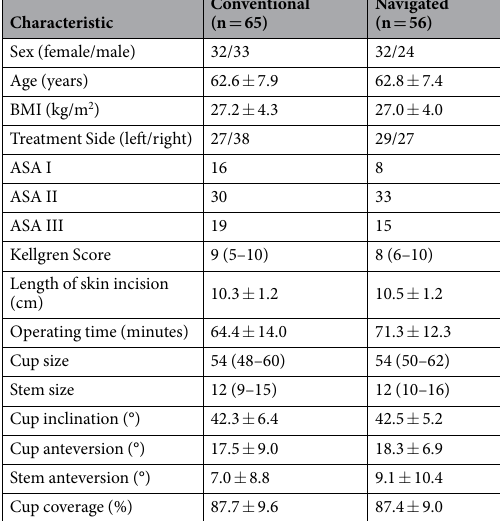
Table 1. Patient characteristics and intraoperative data in this